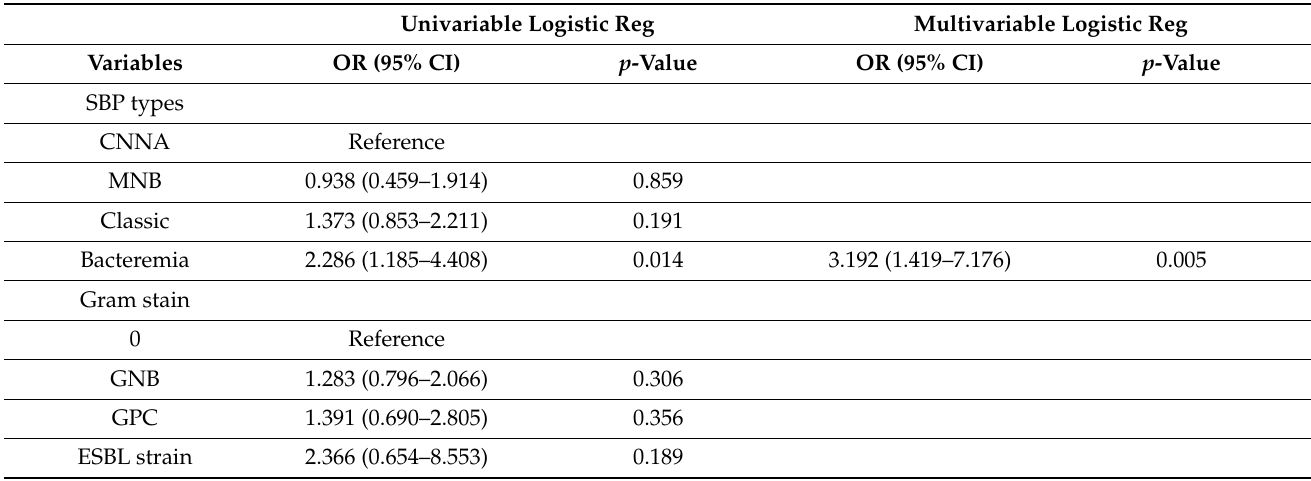
Table 5. Univariable and multivariable logistic regression analysis for predicting in-hospital mortality. Univariable Logistic